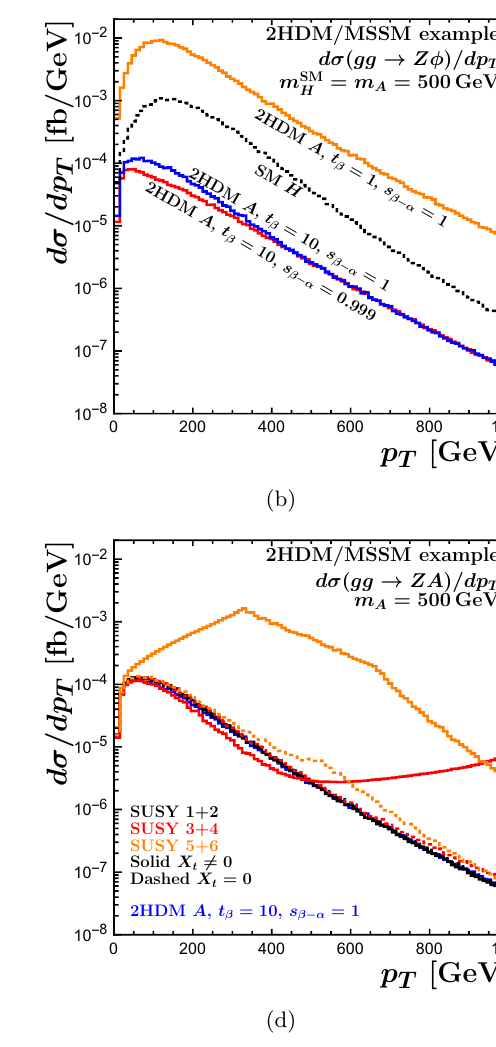
Figure 8 . Invariant mass M Z(cid:30) and p T distributions for a pseudoscalar A with mass m A = 500 GeV produced in gg ! ZA at the 13 TeV LHC : (a) and (b) compare the distributions of a SM Higgs (with m H = 500 GeV) and di(cid:11)erent 2HDM scenarios; (c) and (d) compare the pure 2HDM case with tan (cid:12) = 10 and decoupling sin( (cid:12) (cid:0) (cid:11) ) = 1 with additional squark contributions. The SUSY scenarios are de(cid:12)ned in table